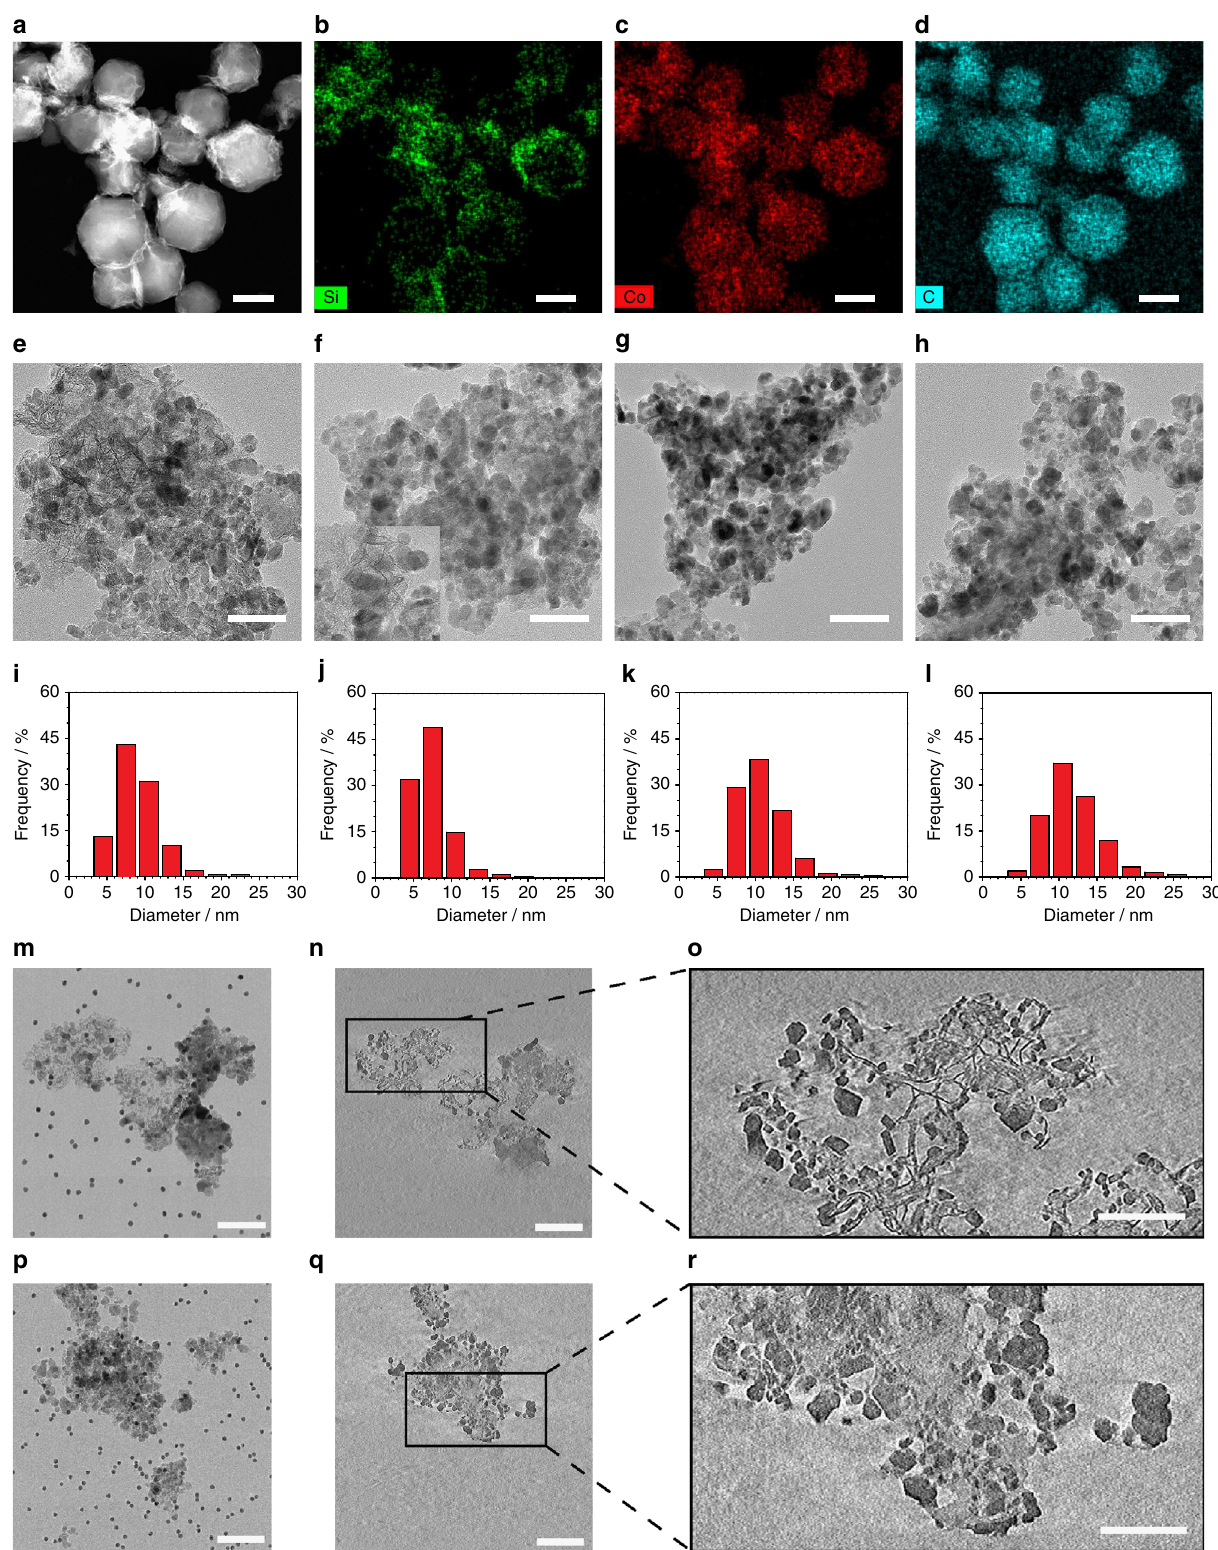
Fig. 2 Electron microscopy images and corresponding nanoparticle size distributions of cobalt based samples. a High-angle annular dark- fi eld scanning electron (HAADF-STEM) micrograph of ZIF-67@SiO 2 (scale bar 200 nm). Elemental mapping of b Si, c Co, and d C in ZIF-67@SiO 2 sample (scale bars 200 nm). TEM micrograph of e Co@SiO 2 - cal , f Co@SiO 2 - 773 with an inset of the observable needle-like structure, g Co@SiO 2 - 873 and h Co@SiO 2 - 973 (scale bars from (e) – (h) 50 nm). Particle size histograms obtained from TEM analysis for i Co@SiO 2 - cal , j Co@SiO 2 - 773 , k Co@SiO 2 - 873 , and l Co@SiO2- 973 . Electron tomography results for m , n , o Co@SiO cal (scale bar 50, 50, and 100 nm, respectively), and p , q , r Co@SiO 873 (scale bar 50, 50, and 100 2 - 2 - nm,